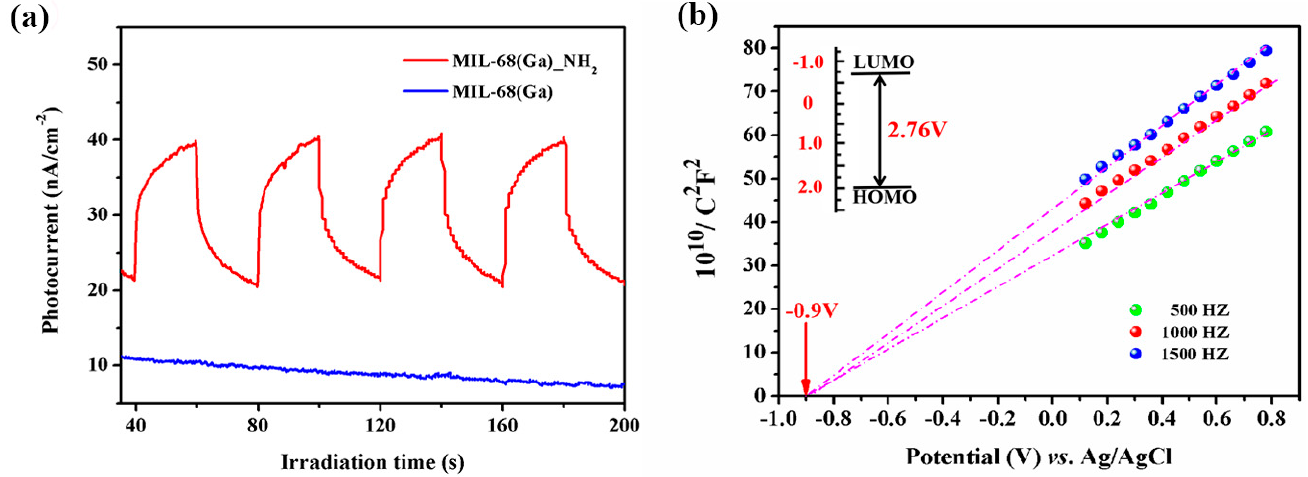
Figure 4. ( a ) Transient photocurrent response of MIL-68(Ga)_NH 2 and MIL-68(Ga). ( b ) Typical Mott–Schottky plots of MIL-68(Ga)_NH 2 .